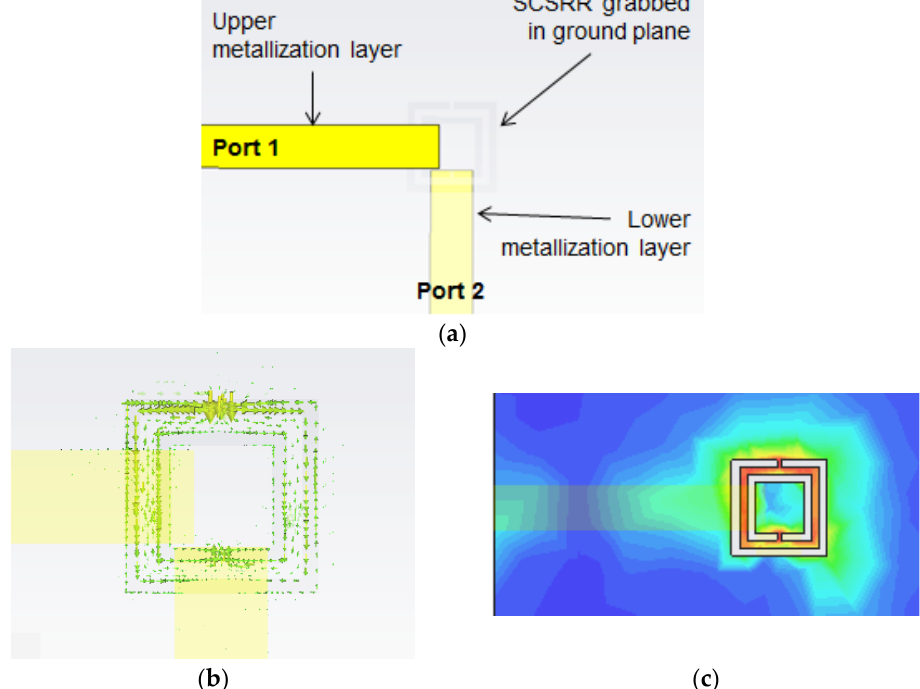
Figure 9. ( a ) Top view perpendicular two-layer resonator and surface current distribution. ( b ) Vector plot of surface current. ( c ) Magnitude plot within the CSRR region .